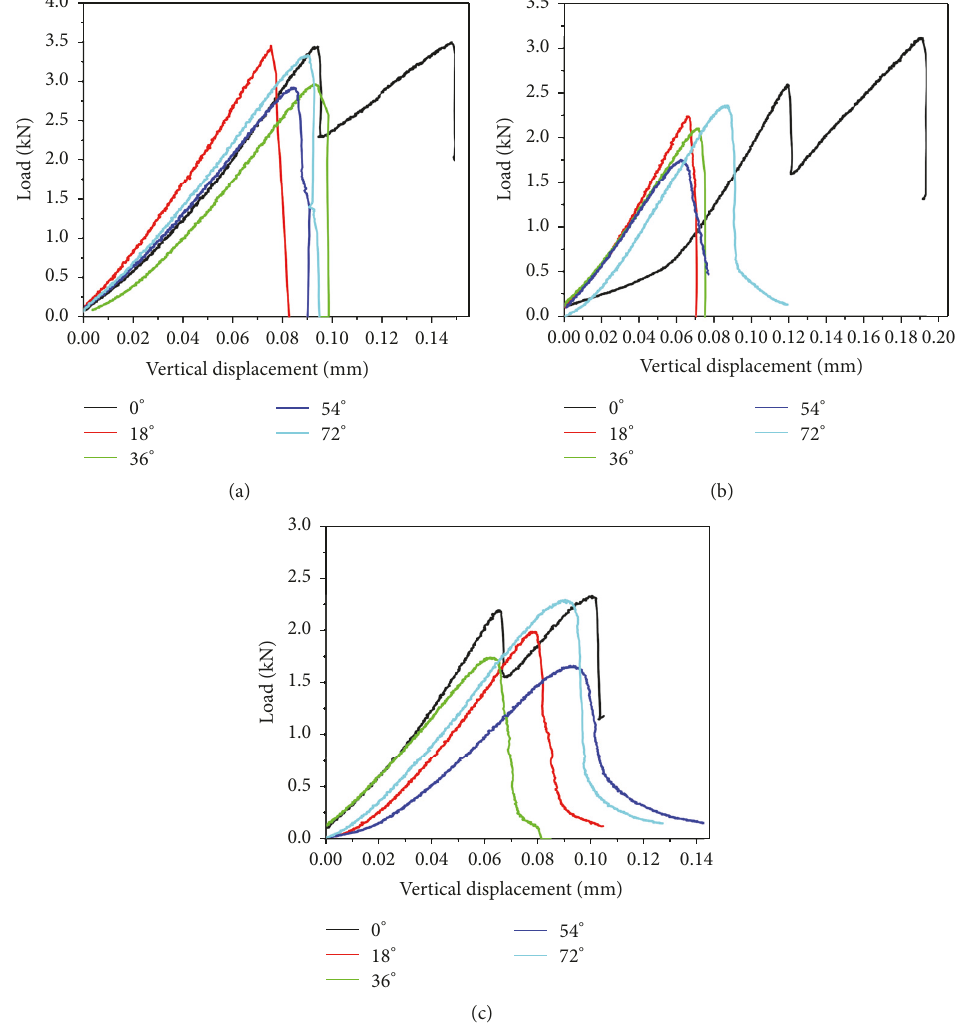
Figure 6: Relationship between load and vertical displacement for each test: (a) 2𝑎 = 15 mm; (b) 2𝑎 = 20 mm; (c) 2𝑎 = 25